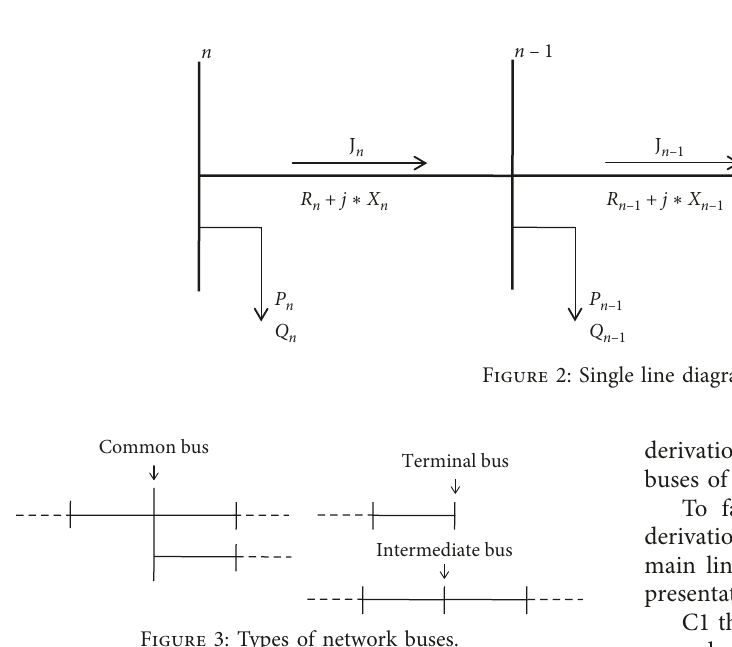
Figure 1: Diagram of the proposed load flow analysis.